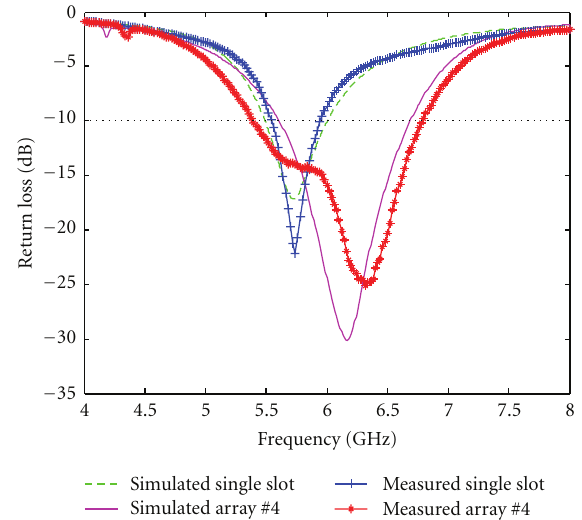
Figure 9: Simulated and measured return loss results of single-slot and four-slot array no. 4 ( d = 14 mm).